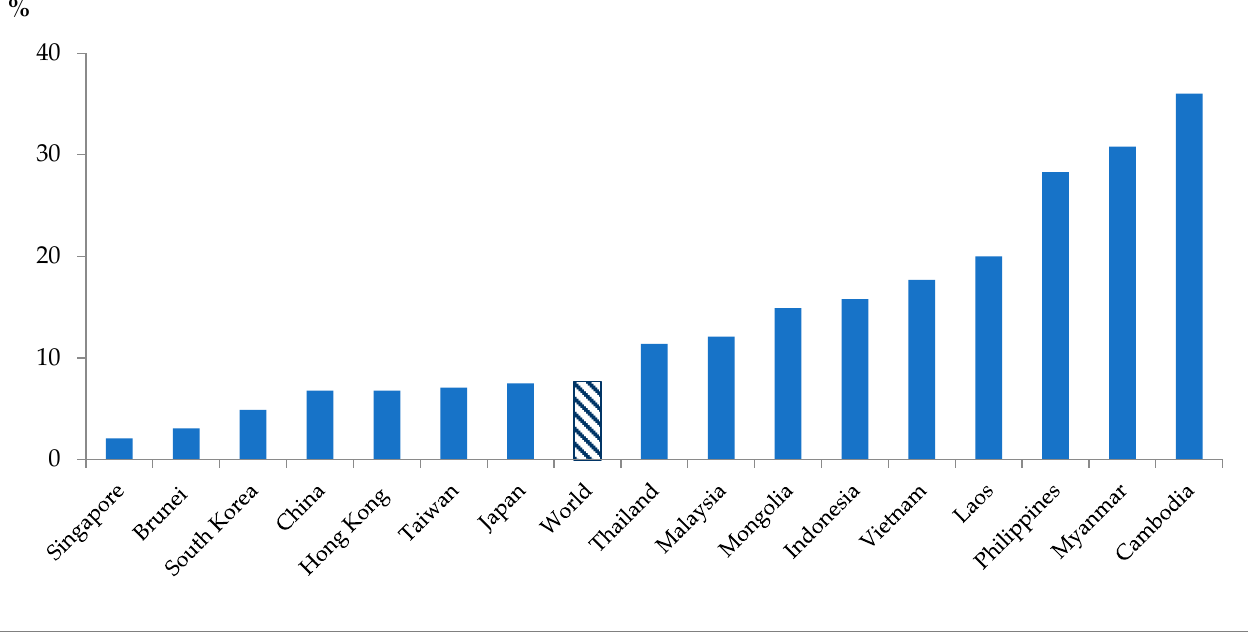
Figure 2. Relationship between the meat SSR (2017–2019), rice SSR (2017–2019), and share of ex- penditure on food in total GDP (2017) for East and Southeast Asian economies (Source: data re- trieved and adapted from [4]). Note: the area of each bubble signifies the share of expenditure on food in the total GDP of each economy. Data on self-sufficiency for North Korea are not available.